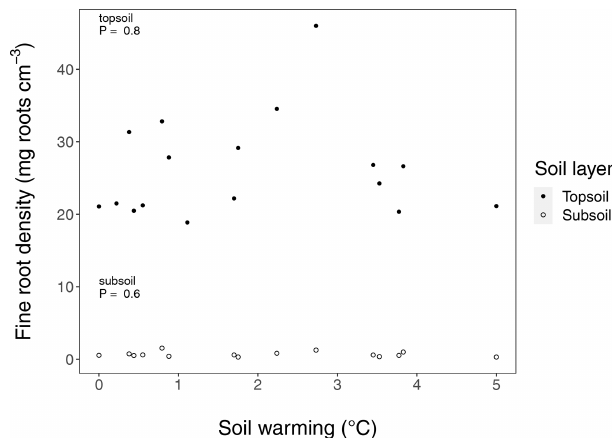
Figure B5. Fine root density in long-term warmed (LTW) grassland in topsoil and subsoil sampled in July 2018. For the observed soil warming range (0–6.4 ◦ C warming), no change in C inputs could be found. P values were obtained by a linear regression analysis. In the top 30cm soil layer, 95.7 ± 0.4 (SE)% of the fine root biomass was found in the upper 10cm, which is why we define the 0–10cm layer as topsoil and the 10–30cm layer as subsoil. ( n = 17 and n = 15 for topsoil and subsoil